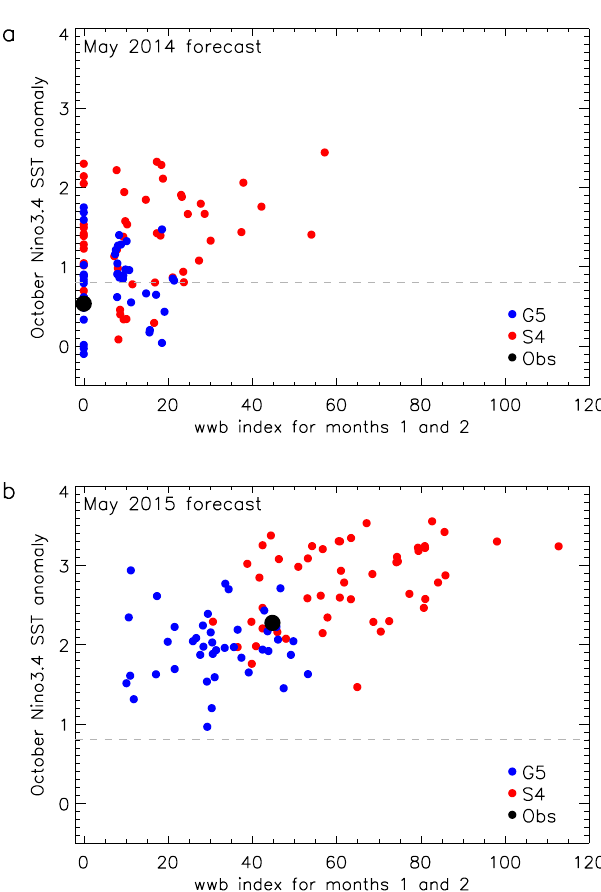
Figure 6. The impact of westerly wind bursts on El Niño development in May 2014 and May 2015 forecasts. Scatter diagram of forecast ensemble members showing October Niño 3.4 SST anomaly against a westerly wind burst index (see Methods) made for the first two months of the forecast for G5 (blue circles) and S4 (red circles). Observations (black circles) are HadISST1.1 and ERA-Interim (u10 winds). The dashed grey line indicates the 0.8 °C